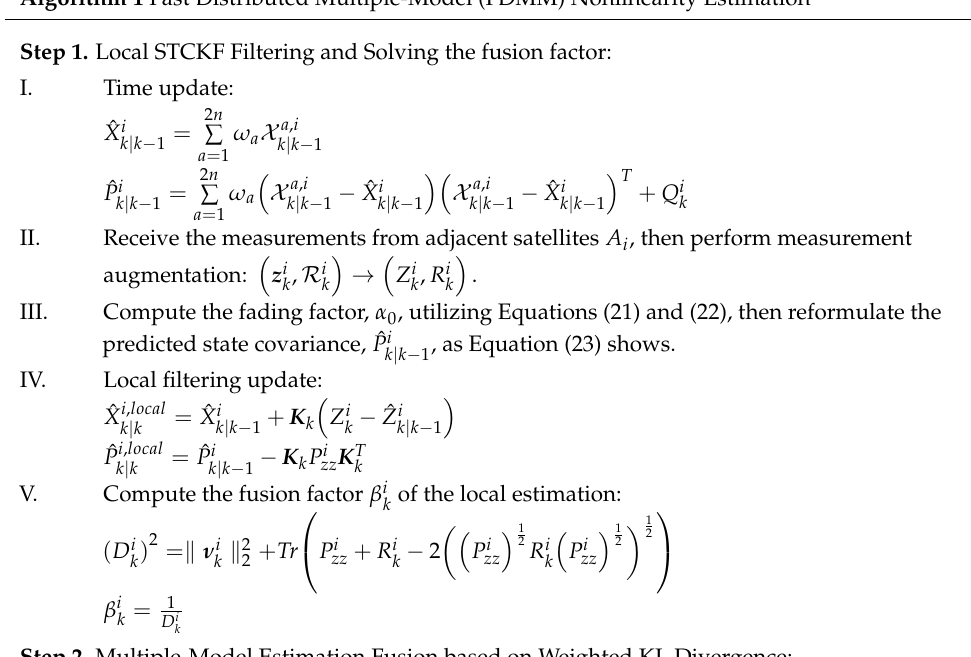
Algorithm 1 Fast Distributed Multiple-Model (FDMM) Nonlinearity